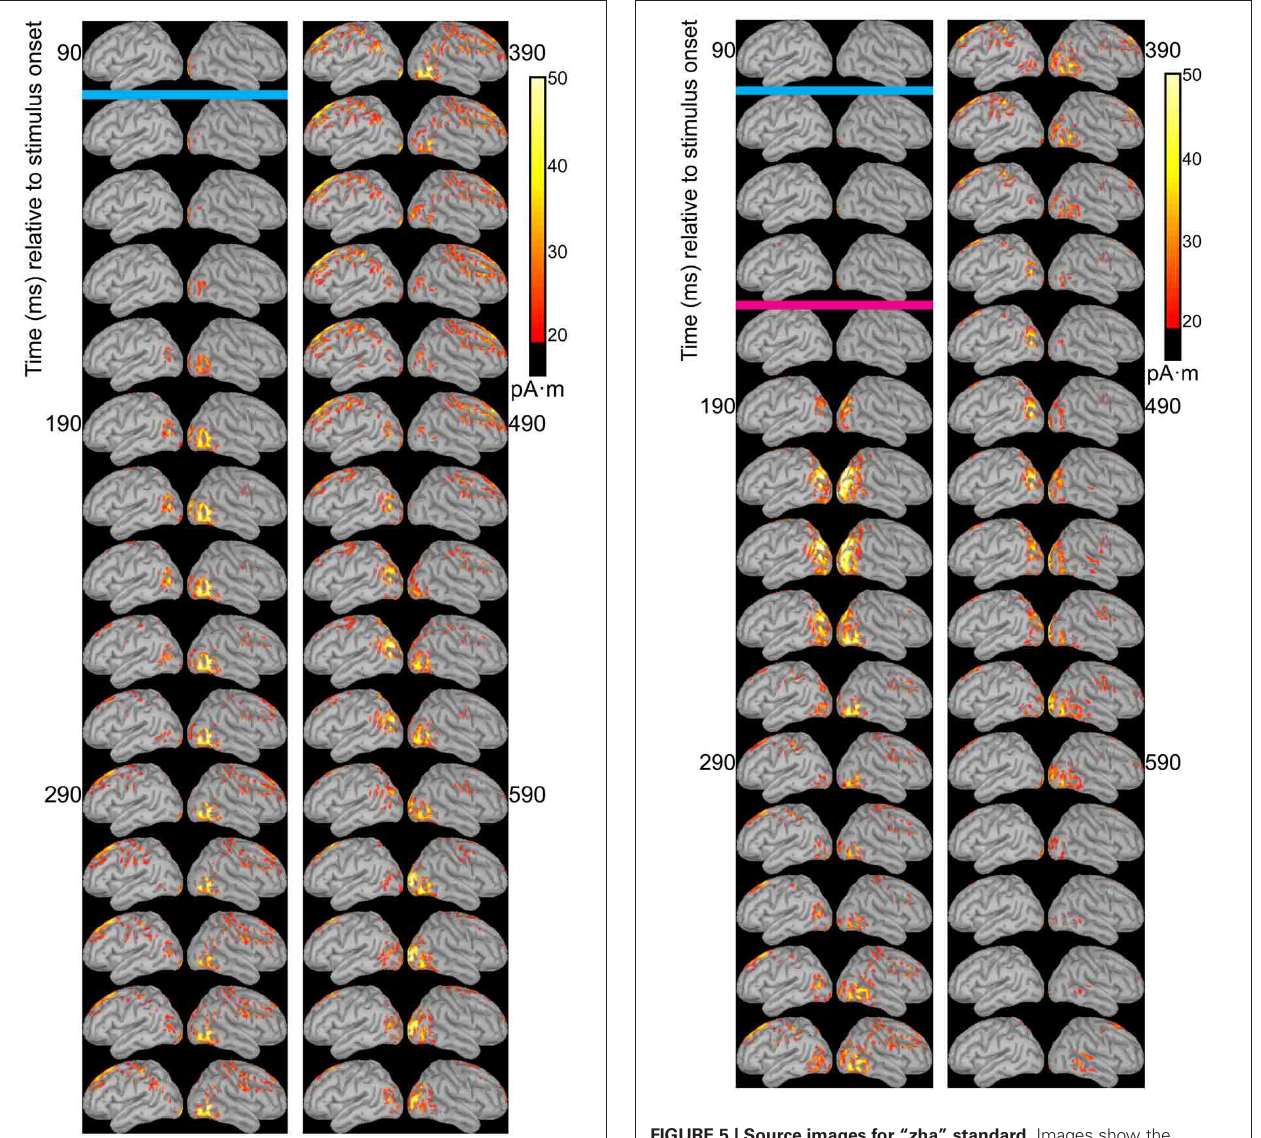
FIGURE 5 | Source images for “zha” standard. Images show the depth-weighted minimum norm estimate of dipole source strength constrained to the surface of the cortex using a boundary element forward model and a generic anatomical model at 20-ms intervals starting from 90ms after the onset of visible motion for the group mean ERPs for syllable “zha” as standard . The cyan bar indicates the time at which “zha” visibly differs from “fa,” and the magenta bar indicates the time at which “zha” visibly differs from “ta.” Images are thresholded at 20pA · m. Initial activity is in the occipital cortex. At 190ms after syllable onset, strong, widespread bilateral posterior temporal activity begins that lasts until 290ms, with weaker activations recurring through 610ms post-stimulus onset. Activation in the right posterior temporal cortex is more widespread and inferior to that on the left. Fronto-central activity is visible from 270 to 490ms post-stimulus